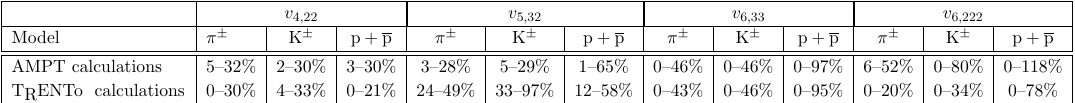
Table 4 . List of minimum and maximum values of the (cid:12)t with a constant function to relative ratios between the data and each model for v n ; mk of (cid:25) (cid:6) , K (cid:6) and p + p. The percentages show deviations of the (cid:12)t from unity obtained for the 0{10% up to 50{60% (40{50% for v 6 ; 33 ) centrality intervals.